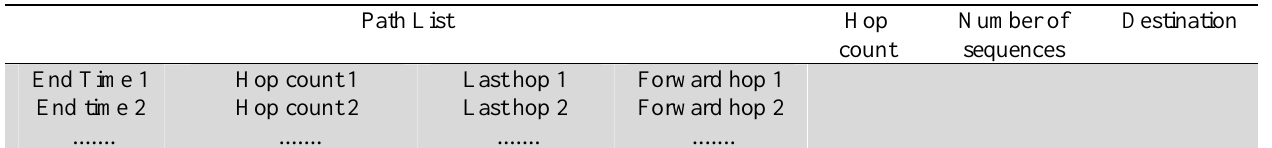
Structure of AOMDV